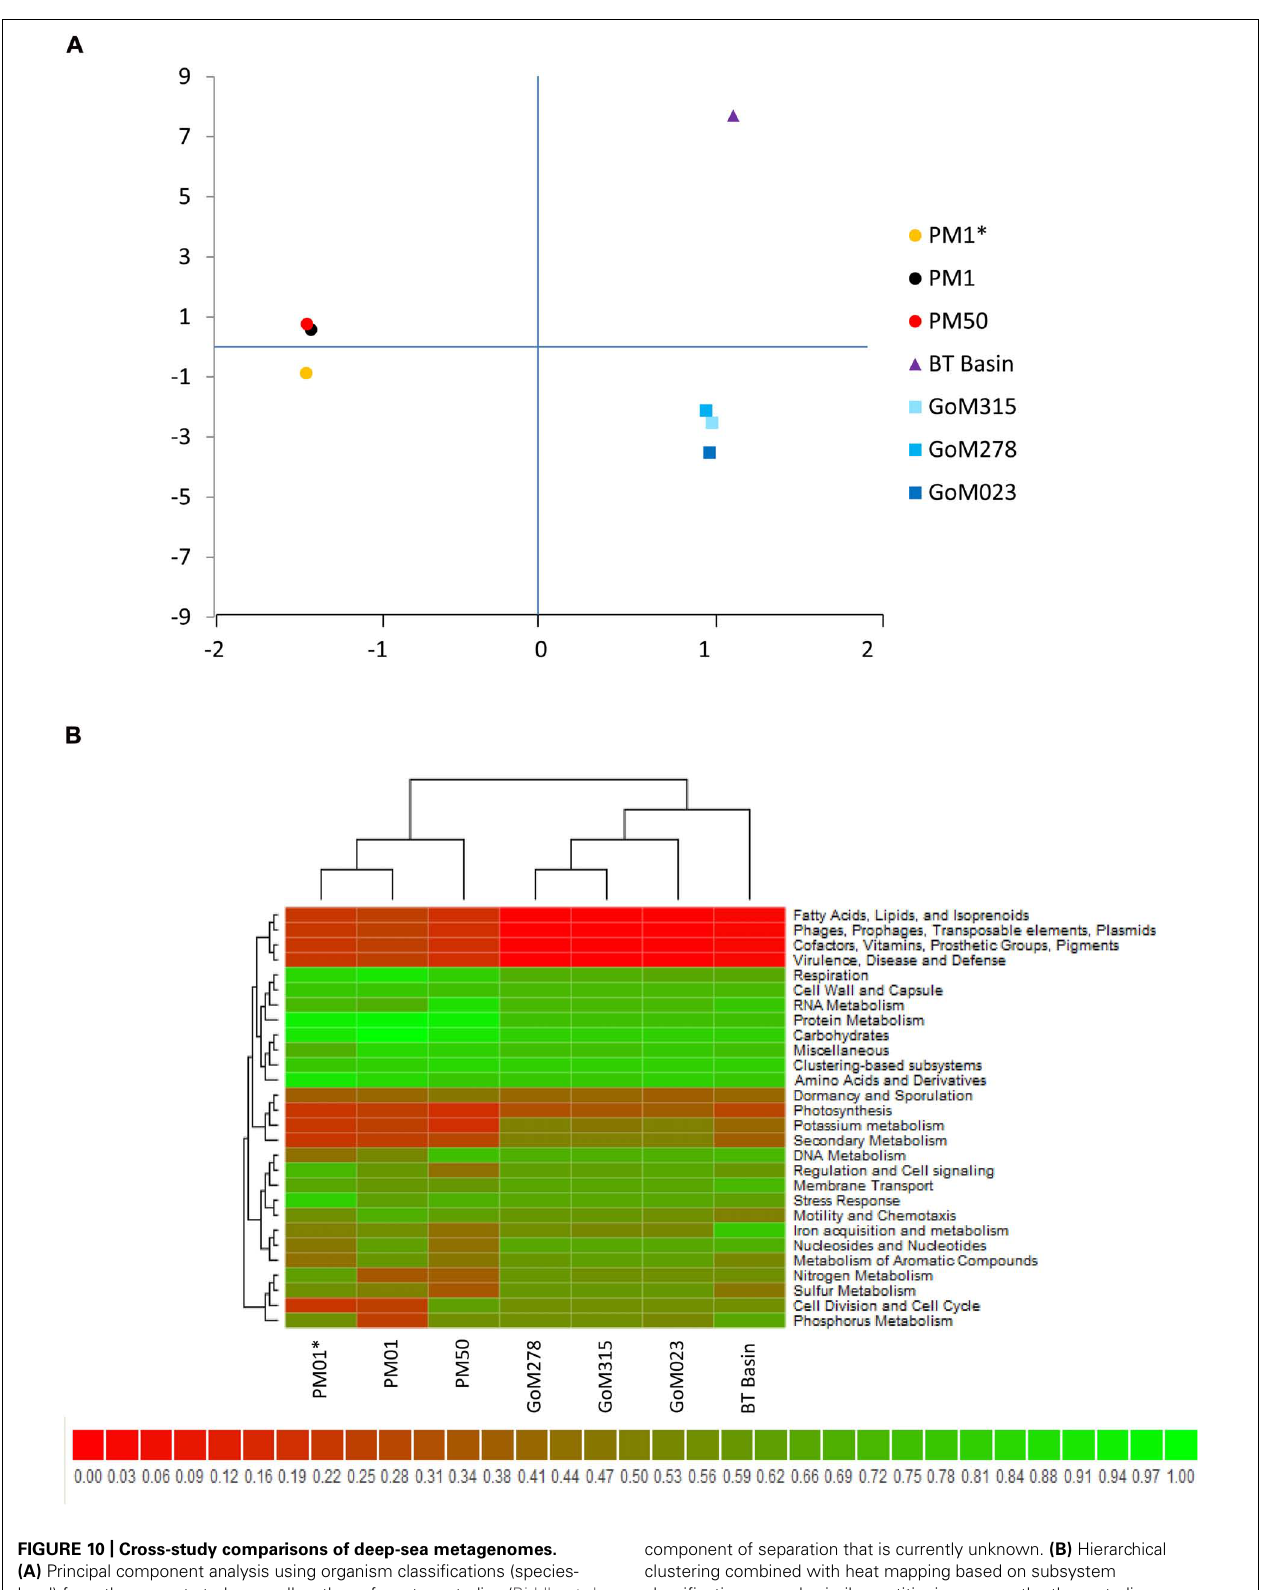
component of separation that is currently unknown. (B) Hierarchical clustering combined with heat mapping based on subsystem classifications reveals similar partitioning among the three studies